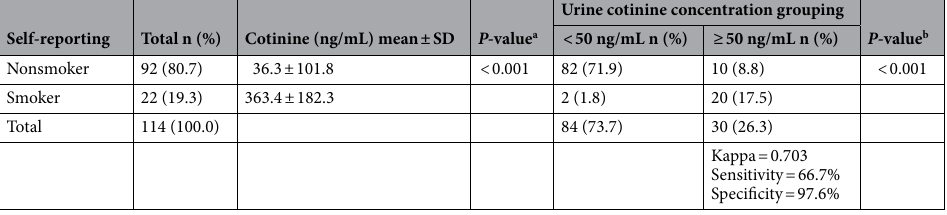
Table 2. Comparison of self-reported smoking behavior and urine cotinine concentration. a Mann–Whitney U test; b Chi-square ( χ 2 ) goodness of fit test.